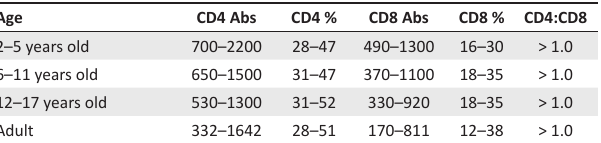
TABLE 2b: Laboratory reference ranges.